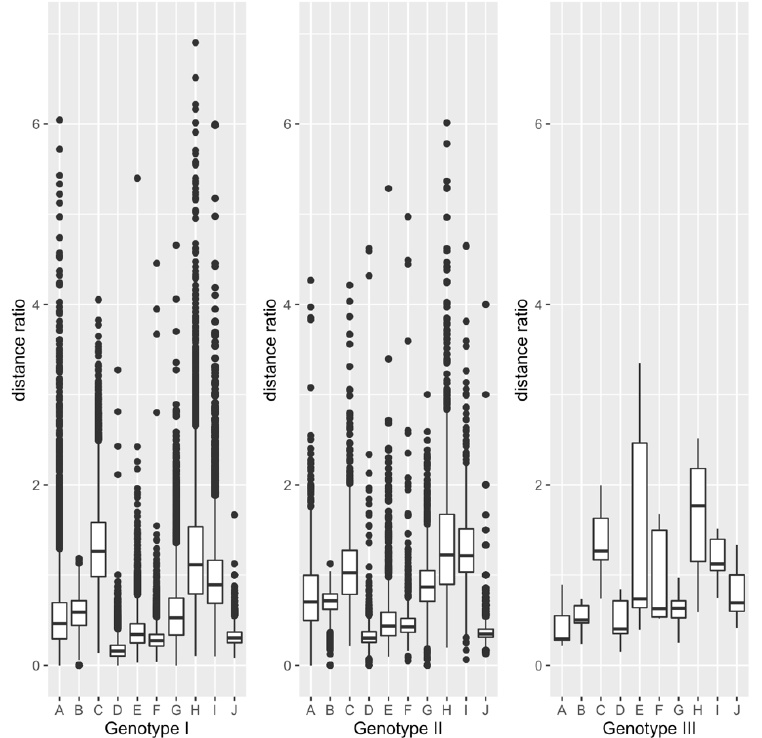
Figure 3. Box plots of ten distance ratios for three genotypes. The ordinate indicates the values of